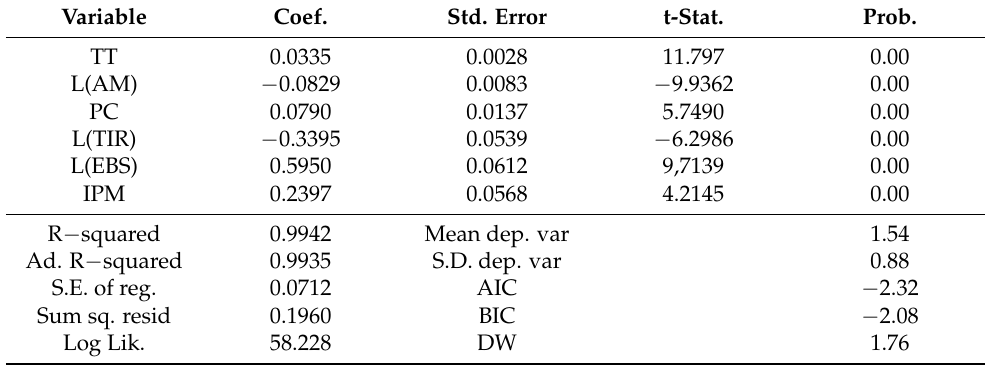
Table 1. Results of the Engle–Granger procedure between annual GDP and variables related to GDP. Variable